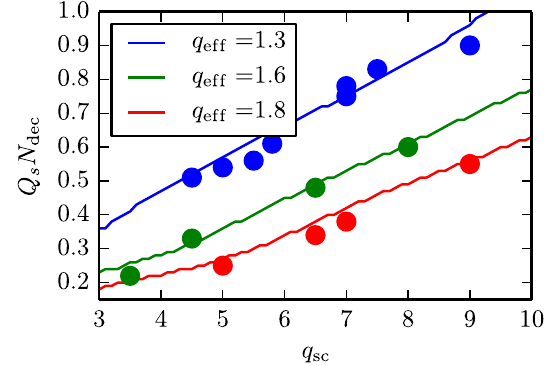
FIG. 19. Summary of the decoherence measurements in SIS18. The points correspond to the decoherence time obtained from the measured signals for different machine and beam parameters. Lines are the characteristic decoherence time from